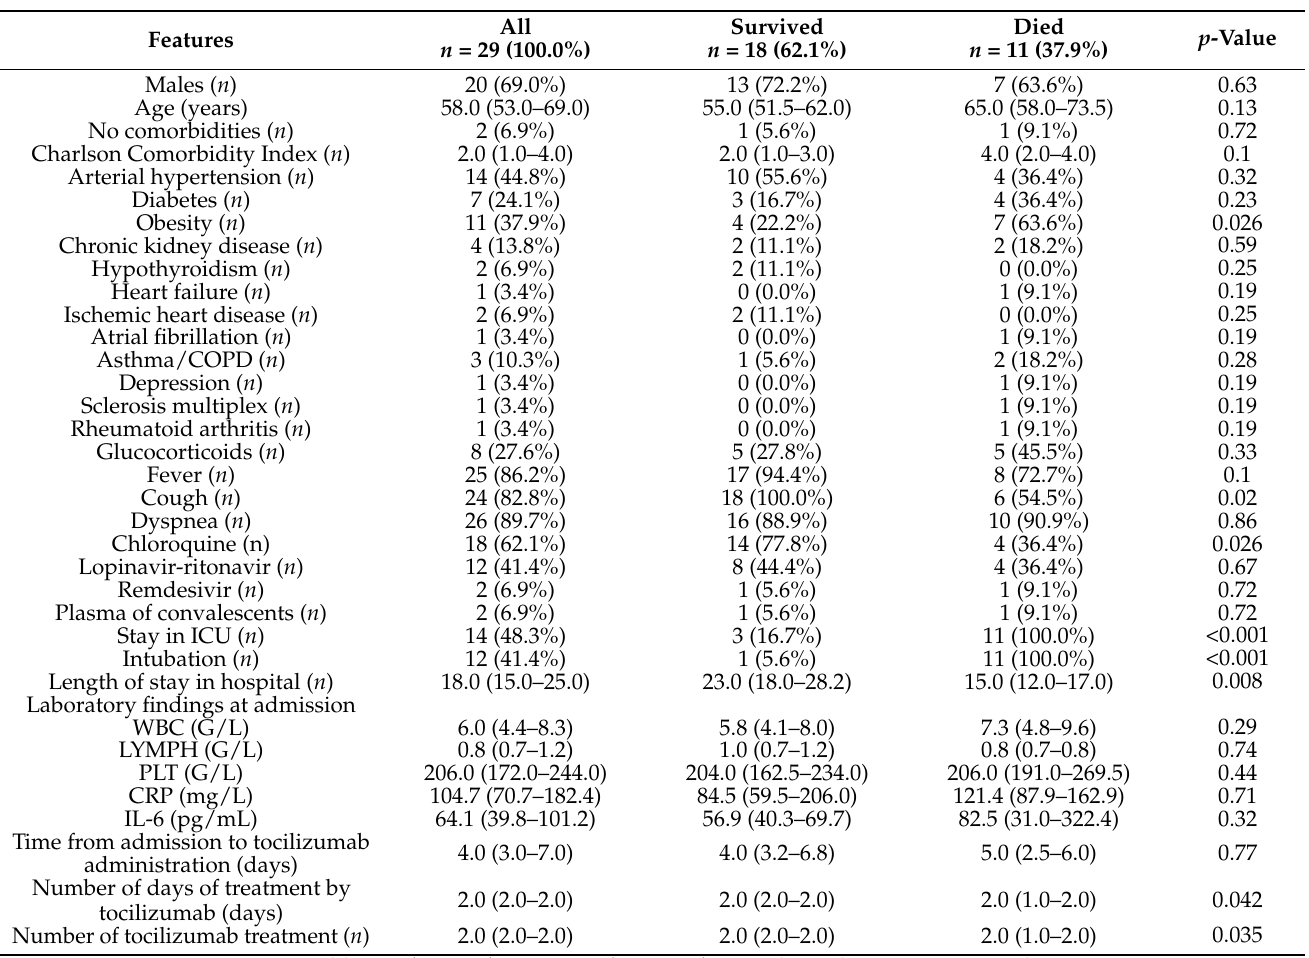
Table 1. General characteristics and comparison of individuals treated with tocilizumab. Data are presented as the median (interquartile range)/ n